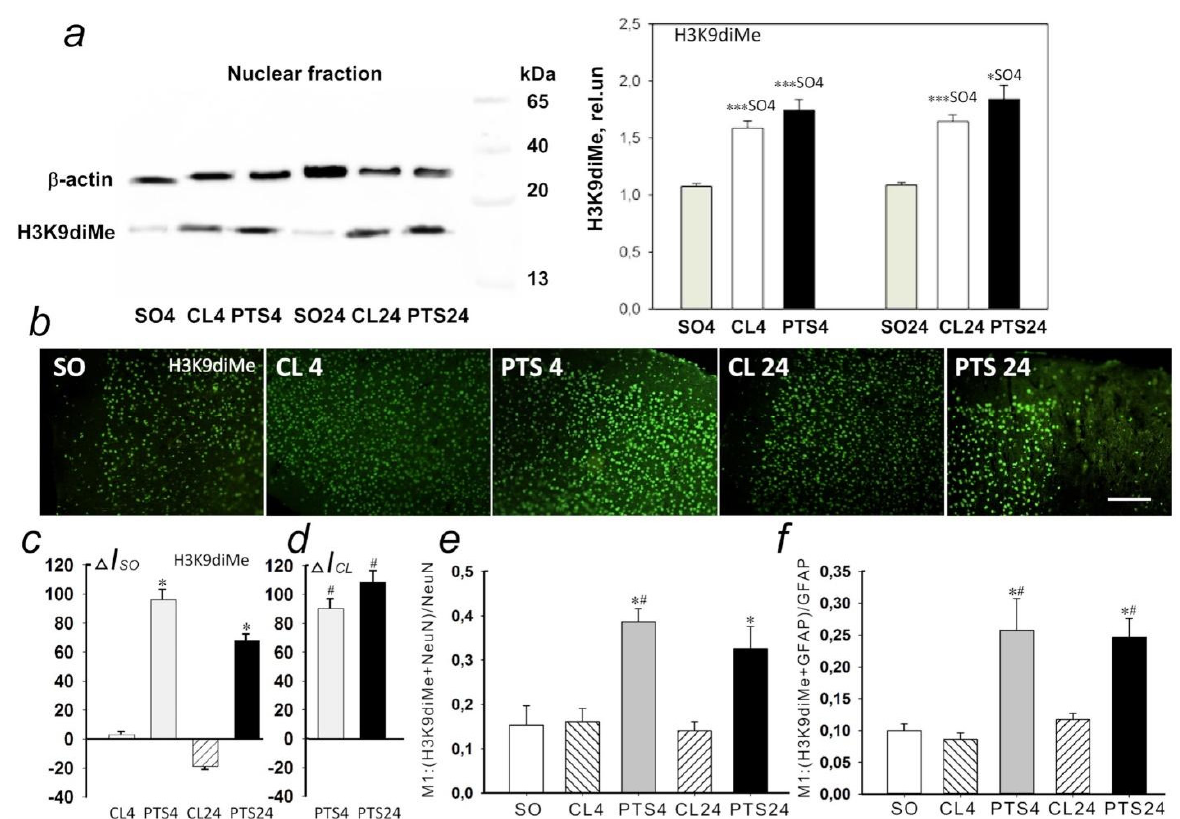
Figure 10. Expression of lysine 9 dimethylated histone H3 (H3K9diMe) in the penumbra and control samples of the cerebral cortex of sham-operated rats (SO) or the cerebral cortex in the contralateral hemisphere of the same animal (CL4 and CL24) at 4 and 24 h after photothrombotic stroke in the right hemisphere of the rat brain (PTS4 and PTS24). ( a ) Western blotting of H3K9diMe in the nuclear fraction of rat brain tissue. One Way ANOVA; M ± SEM, N = 8, * p < 0.05; *** p < 0.001 relative to sham-operated animals. ( b ) Immunofluorescence of H3K9diMe-positive cells in the cerebral cortex of sham-operated rats (SO), in the unirradiated contralateral cortex (CL4 and CL24) and in the penumbra at 4 and 24 h after photothrombotic stroke (PTS4 and PTS24). Scale section: 150 microns. ( c ) Percentage changes in the fluorescence intensity of H3K9diMe-positive cells in the penumbra and contralateral cortex at 4 or 24 h after PTS relative to that in sham-operated animals ( Δ Iso). ( d ) Percentage changes in the fluorescence intensity of H3K9diMe-positive cells in the penumbra at 4 or 24 h after PTS in the rat cerebral cortex relative to the contralateral cortex ( Δ ICL). ANOVA, n = 8, * p < 0.05 relative to sham-operated animals, # p < 0.05 relative to the contralateral hemisphere. ( e , f ) Average values of the M1 colocalization coefficient reflecting the proportion of pixels with a red signal (cellular marker, NeuN ( e ) or GFAP ( f )) containing the green signal (H3K4me) in relation to the common signal from the red channel. M ± SEM, ANOVA, n = 8; * p < 0.05 relative to sham-operated animals; # p < 0.05, relative to the contralateral hemisphere. Rel.un—the ratio of the optical density of the strip of the protein studied to the optical density of the strip of the protein load marker (actin).